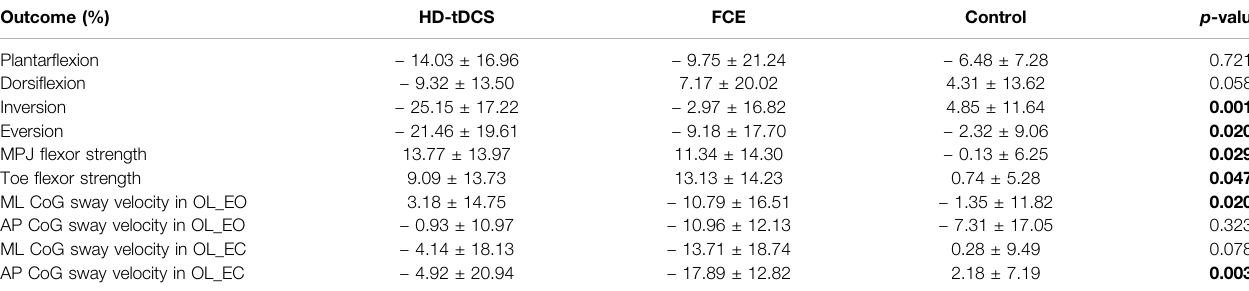
TABLE 3 | Percentage changes in passive ankle kinesthesia, foot muscle strength, and one-leg standing balance from baseline to post-intervention. Outcome (%)